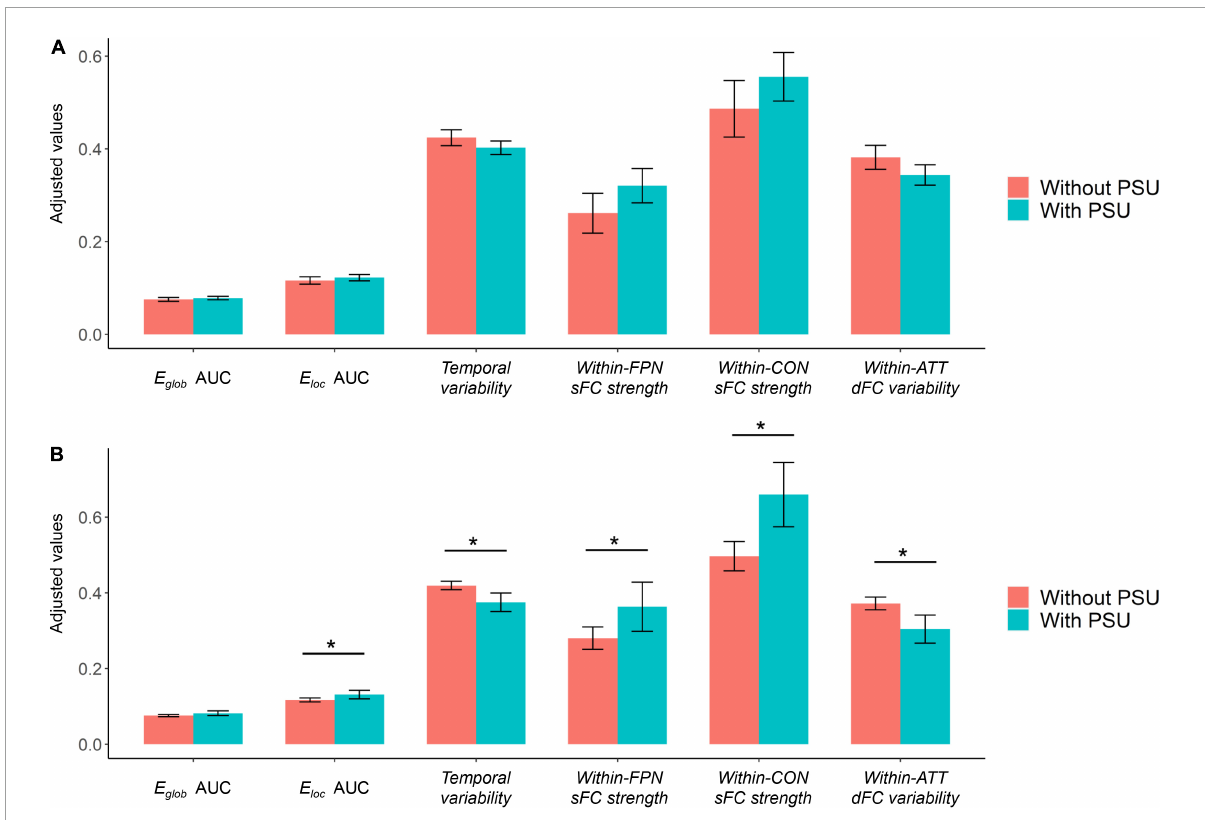
FIGURE5 (A) Results of group comparisons when defining problematic smartphone use with the cutoff proposed in prior research [short version of the smartphone addiction scale (SAS-SV) score ≥ 31 for males and ≥ 33 for females]. (B) Results of exploratory group comparisons when defining problematic smartphone use with a new cutoff (SAS-SV score ≥ 43 for males and ≥ 42 for females, as estimated by one standard deviation above the mean scores). The error bars represent the 95% confidence intervals, and the “*” indicates a significant difference with corrected p < 0.05. ATT, attention subnetwork; CON, cinguloopercular subnetwork; PSU, problematic smartphone